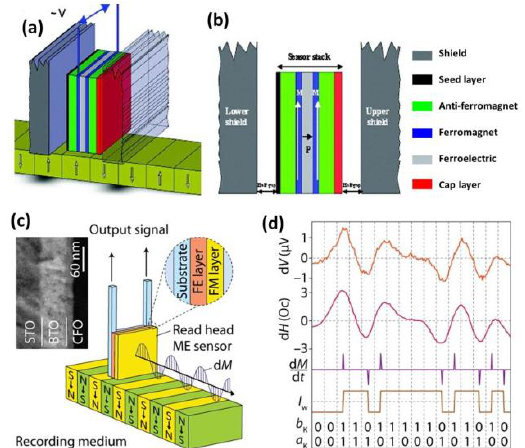
Figure 15. ( a ) and ( b ) 3D diagram and cross-section of the magnetic read head proposed by Vopson et al. [106] ( c ) and ( d ) Schematic, TEM image (inset) and voltage output of an ME read-head sensor